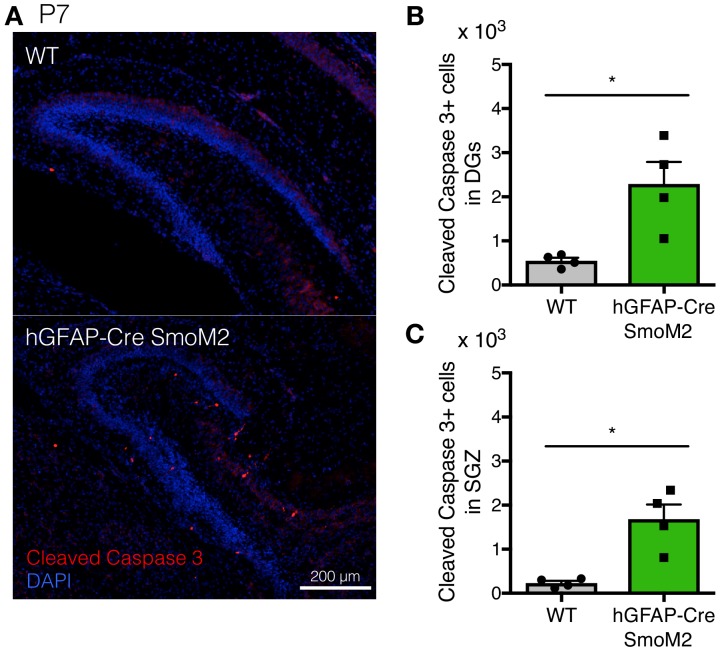
Excessive Shh signaling activity leads to abnormal morphology of DGs and increased cell death.(A) Representative immunofluorescence images of Cleaved Caspase 3 (red) and DAPI (blue) in the DG of WT and hGFAP-Cre;SmoM2 mice at P7. (B, C) Quantification of Cleaved Caspase 3 + cells in the DGs (B) and SGZ (C) [n = 4 biological replicates per group]. Values represent mean ±SEM; ns: p>0.05, *p<0.05, **p<0.01. Welch’s t-test.10.7554/eLife.42918.007Figure 2—figure supplement 1—source data 1.Extended numerical data and statistical analysis for Figure 2.